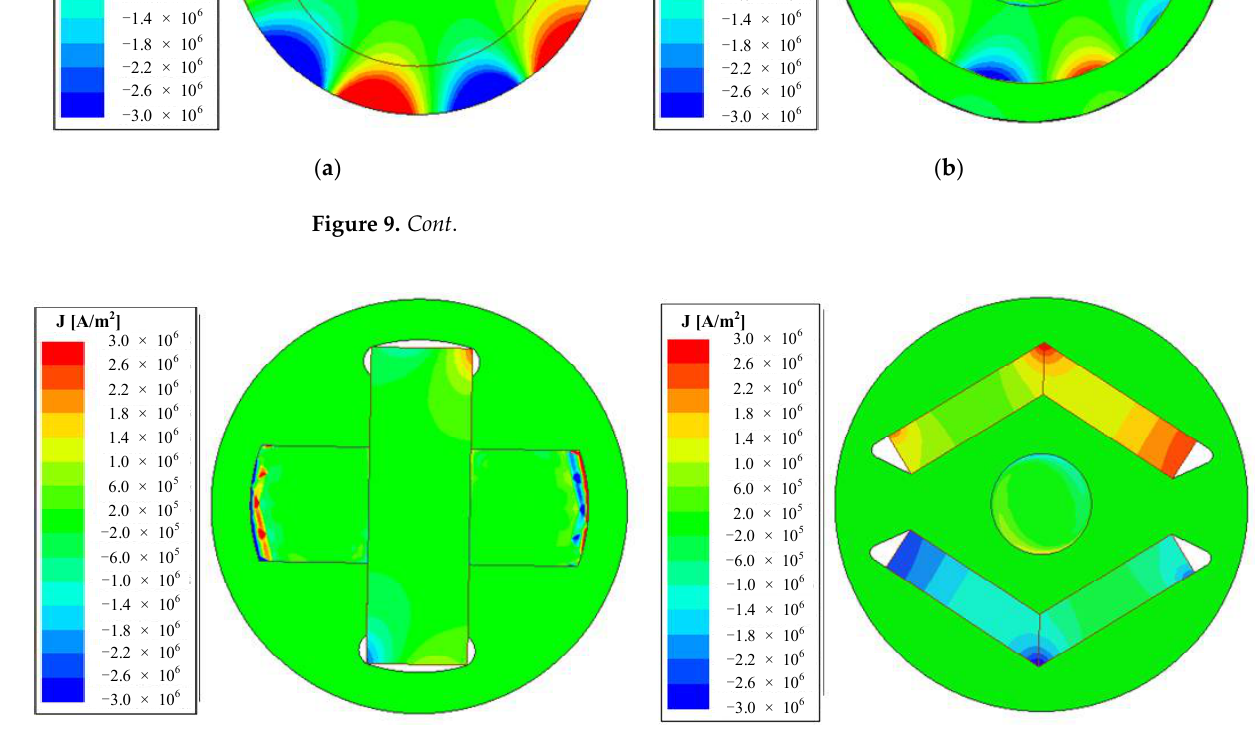
Figure 9. Eddy-current loss distribution in rotor at rated state (160 krpm). ( a ) M1; ( b ) M2; ( c ) M3; ( d ) M4.